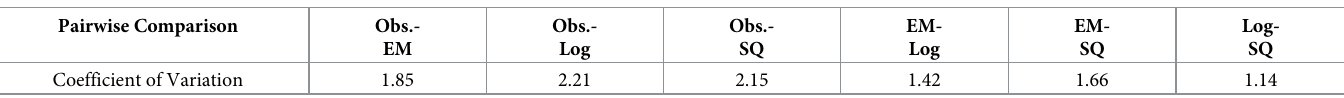
Table 5. Coefficient of variation across six pairwise comparisons of human observers (‘Obs.’), electronic monitoring (‘EM’), detailed logbooks (‘Log’), and the status quo (‘SQ’) alternatives for data collection at sea. Pairwise Comparison